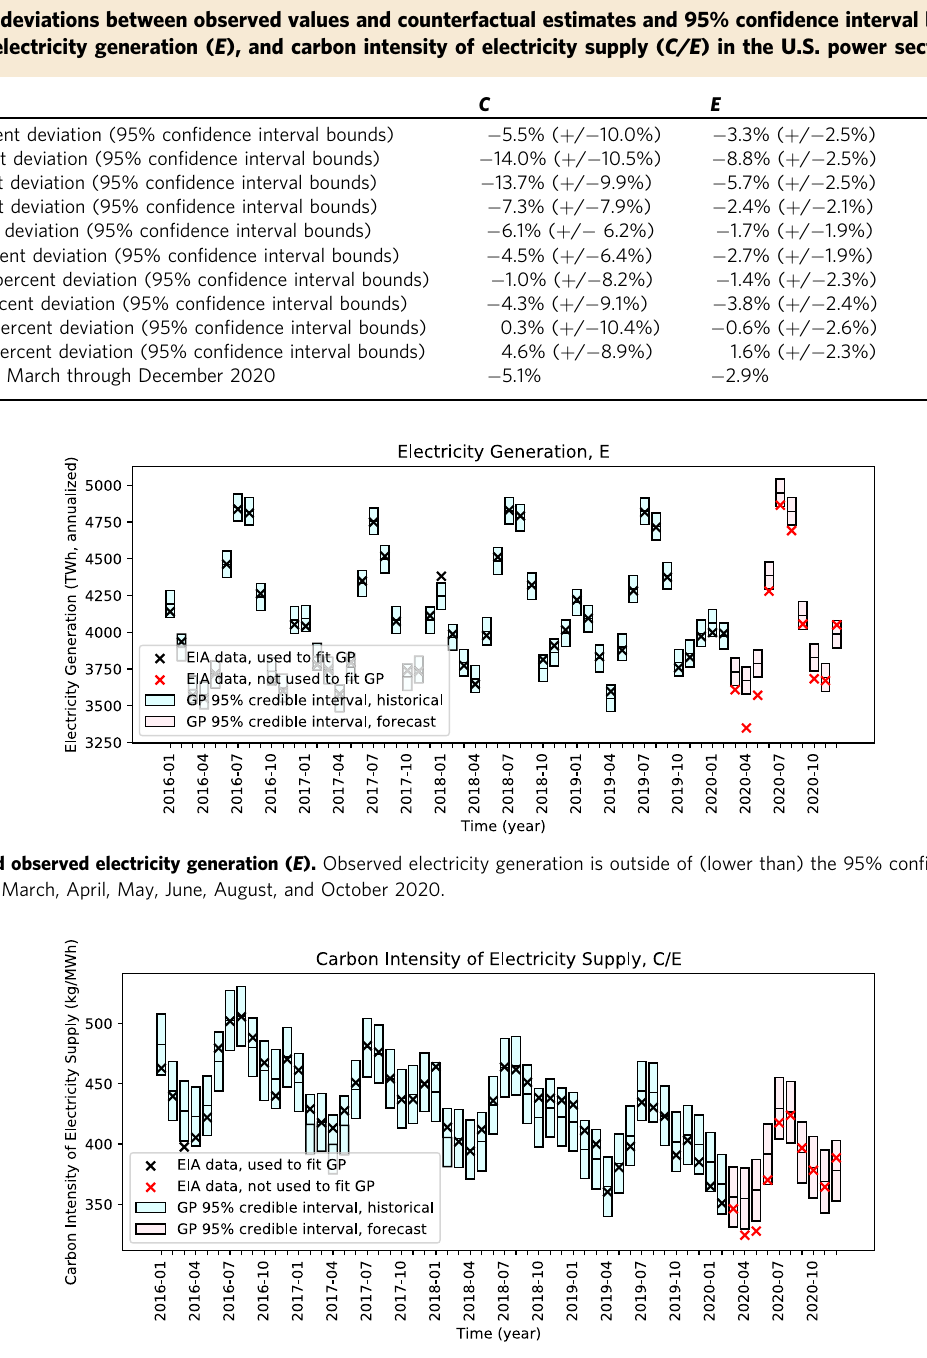
Fig. 3 Expected and observed carbon intensity of electricity supply ( C/E ). Observed carbon intensity of electricity supply is outside of (lower than) the 95% con fi dence intervals in two forecasted months: April and May 2020. Table 2 Average counterfactual and observed power sector CO 2 emissions ( C ) attributable to coal, natural gas, and oil, March to December 2020, contiguous U.S.; and average percent deviations between counterfactual and observed emissions for each fuel